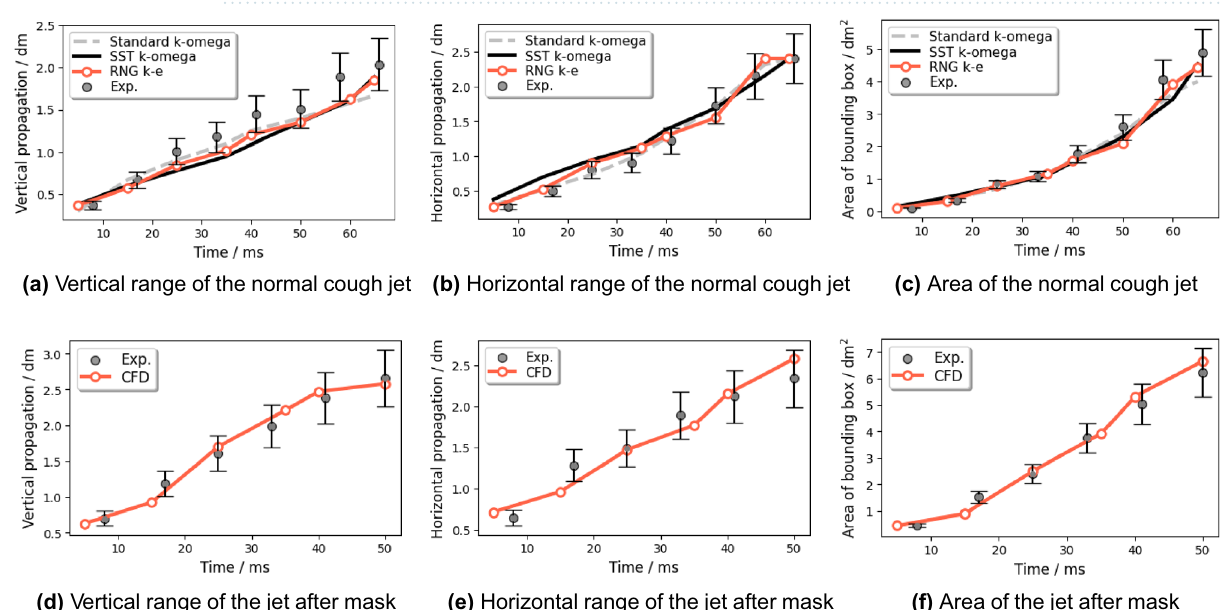
Figure 17. Typical cough with single-layer gauze mask from CFD and Schlieren experiment. The figure was processed by Ansys Fluent (version 2019 R2) and drawn in Adobe Illustrator (version 16.0).